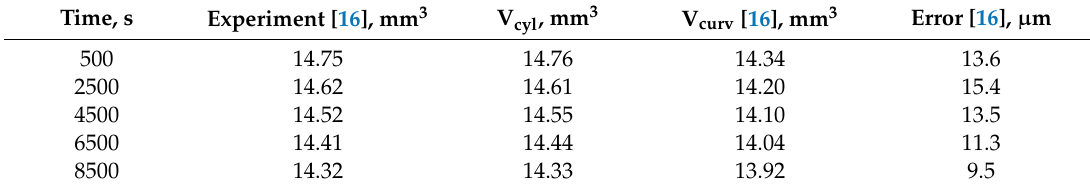
Table 1. Results obtained using di ff erent methods to determine water drop